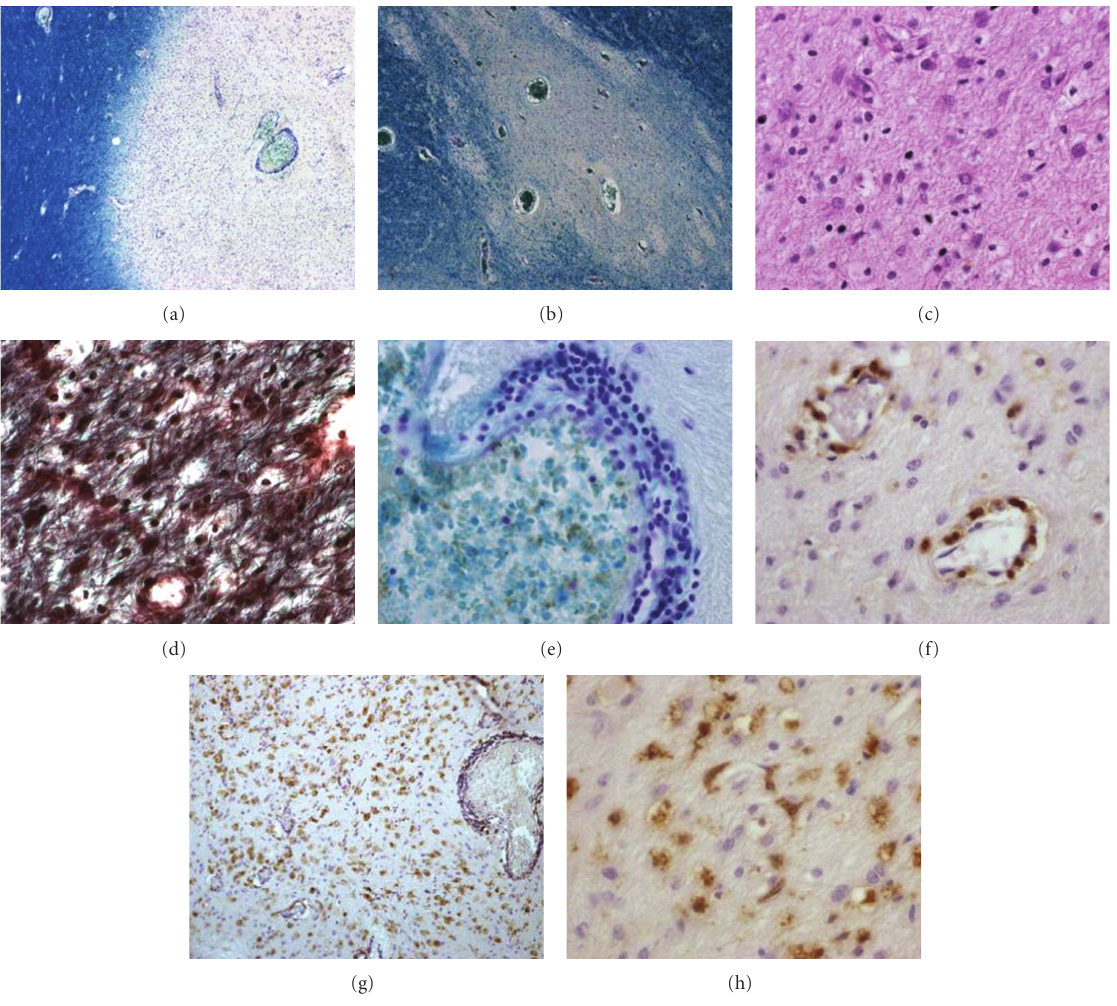
Figure 1: Microphotographs of the lesion in the occipital lobe showing a sharply demarcated area of demyelination ((a) and (b) Luxol- Fast-Blue, magnification 4X), reactive astrogliosis ((c), (h), and (e) stain, magnification 100X), and una ff ected nerve fibers ((d) Bodian stain, magnification 200X). Note the perivascular lymphocytic infiltrates ((e) Luxol-Fast-Blue stain, magnification 100X), perivascular T-lymphocytic infiltrates and lymphocytes in the surrounding parenchyma ((f) UHCL antibody, magnification 200X), and activated macrophages/microglia within the demyelinated area (CR3/43 antibody; (g) magnification 25X, (h) magnification